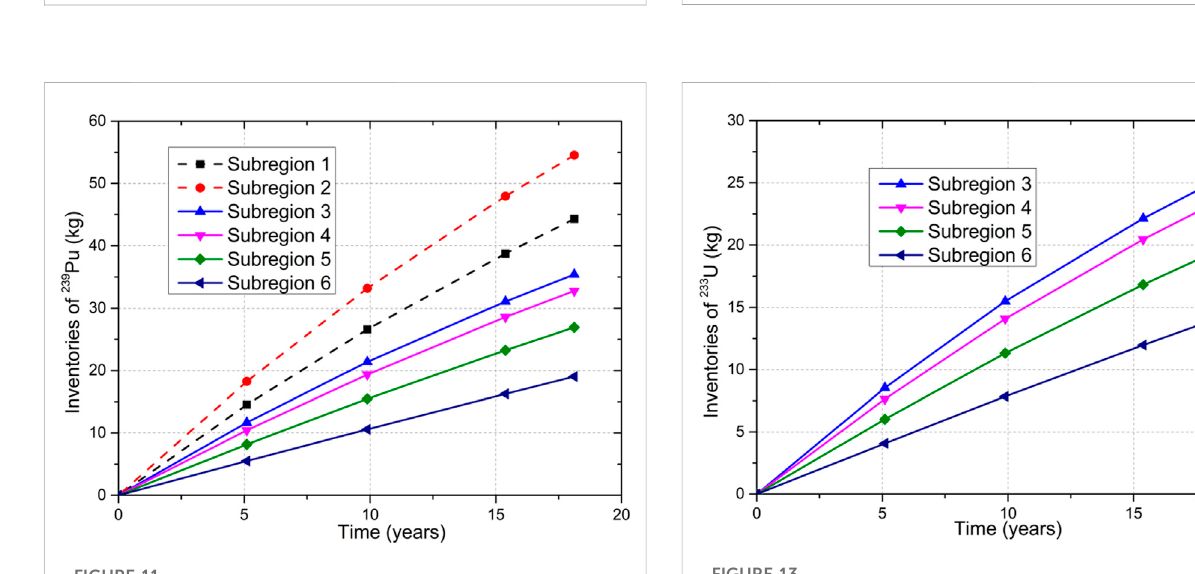
FIGURE 11 Time evolutions of 239 Pu inventories in the subregions.